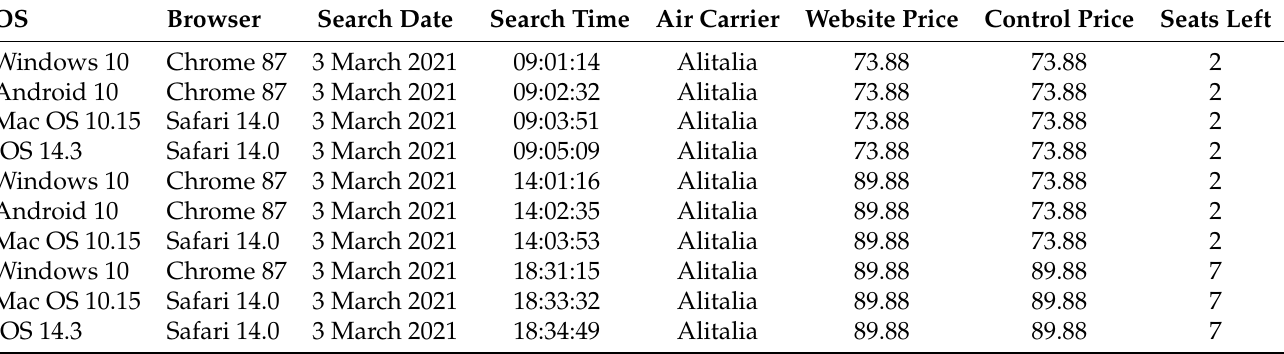
Table 3. Price difference detected: website price higher than